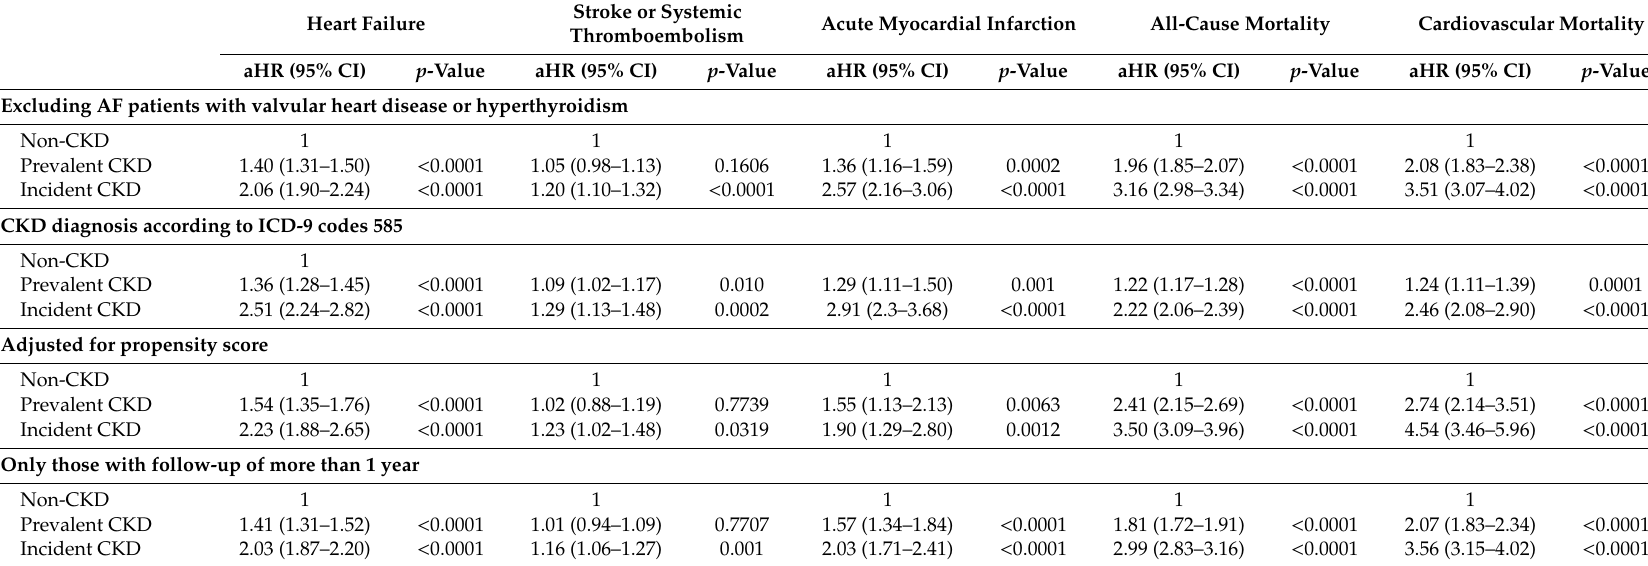
Table 4. Sensitivity